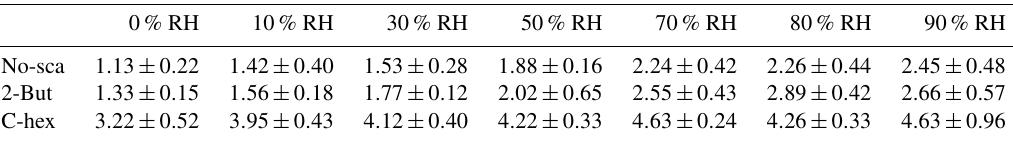
Table 2. H 2 O 2 generation per particle mass (ngug − 1 ) in SOA formed with different OH scavengers in the relative humidity (RH) range of 0%–90% at a low [O 3 ] / [limonene]